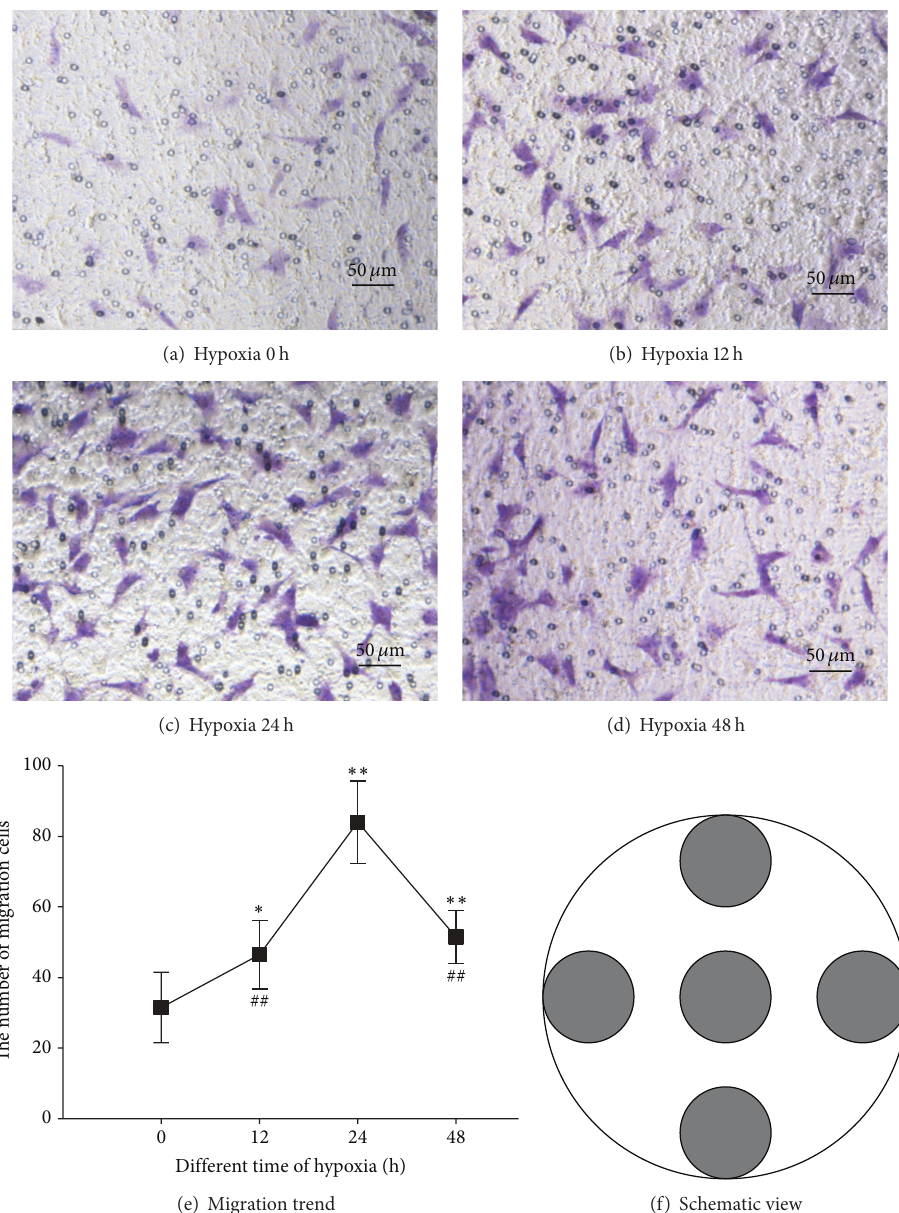
Figure 3: Supernatant of hypoxia induced CFs promoted CSCs migration. (a) shows CFs were exposed as control under normoxia while (b) (12h), (c) (24h), and (d) (48h) demonstrate that CFs were cultured under different time period of hypoxia. (e) reveals the migration curve under different periods of hypoxia that peaks at 24 h. (f) denotes CSCs migration accounts in the well are counted according to the fixed location. ∗ indicates 𝑃 < 0.05 compared to the 0h group. ∗∗ indicates 𝑃 < 0.01 compared to the 0h group. ## indicates 𝑃 < 0.01 compared to the 24h